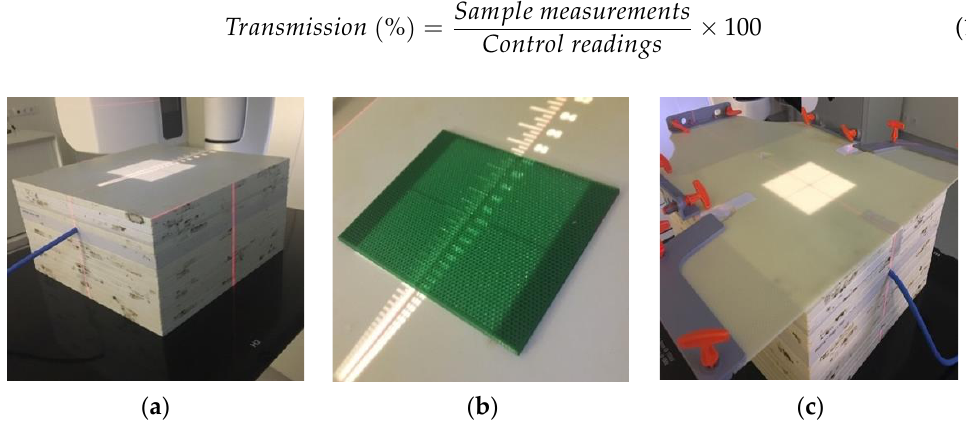
Figure 2. ( a ) Ionization chamber set-up. ( b ) Placement of the plate on the ionization chamber. ( c ) Conventional mask set-up on the ionization chamber.